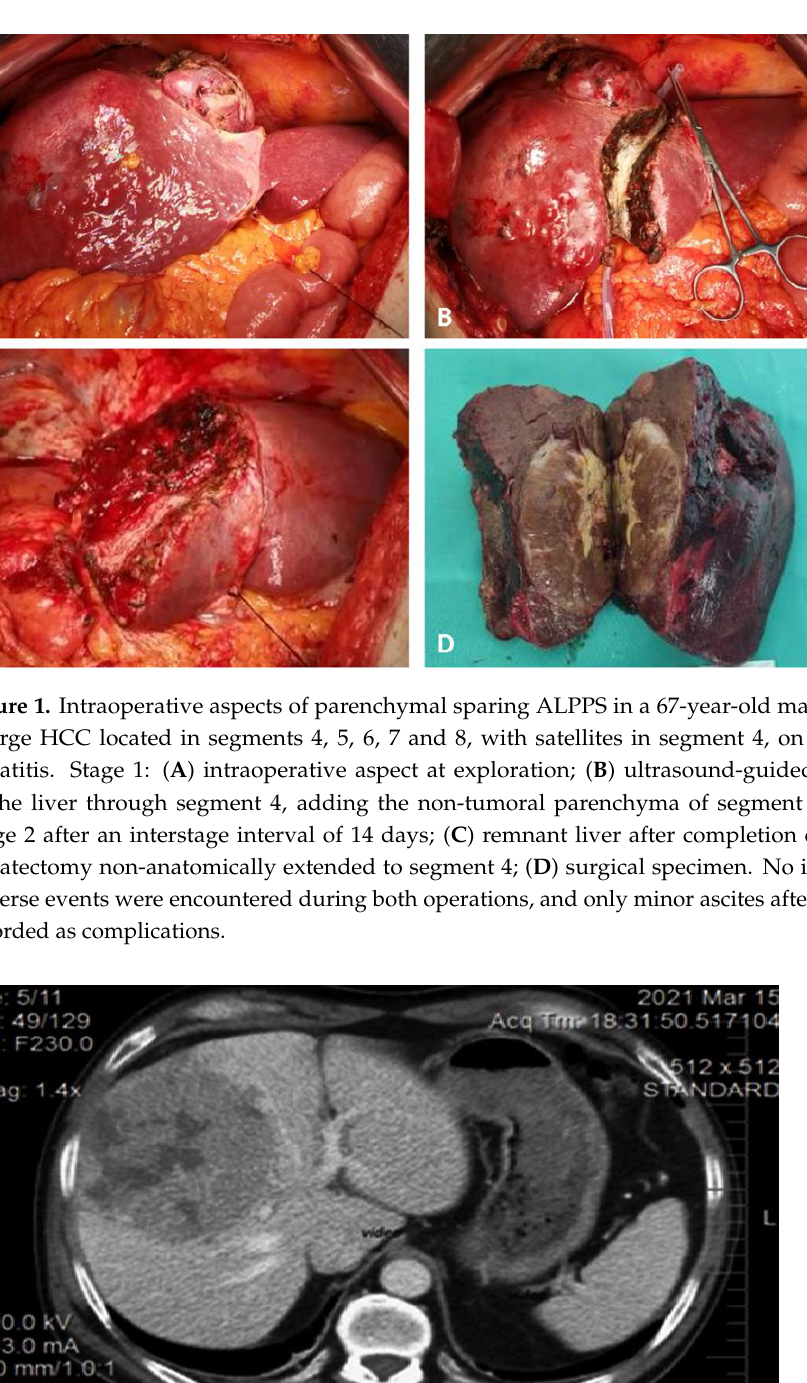
Figure 2. ( A ). Preoperative CT showing the large HCC located in segments 5 and 8 with extension to segments 6, 7, 4, compressing the middle hepatic vein; volumetry: volume of segments 2 and 3 16.8% of total functional liver volume, volume of FLR 27.8%. ( B ) Interstage CT showing the liver partitioning, absence of contrast in the right portal vein (due to ligation), and sufficient growth of FLR (38.5% of total functional liver volume). ( C ) Postoperative CT with well-perfused, non-dilated bile ducts, and tumor-free remnant liver. Besides being the best available tool for identifying and mapping the focal liver le- sions in real time, IOUS increases the safety of ALPPS and its variants by identifying the anatomic variants of the portal vein bifurcation and guiding the right portal vein ligation and the liver transection. 4. Parenchyma-Sparing vs. Regenerative Liver Surgery Interestingly, both strategies have the same origin, as they were basically devised by Makuuchi et al., who pioneered PSS [25] by promoting ultrasound-guided LR and RS by devising portal vein embolization [31]. Even though “siblings”, they become “enemies” caught in the PPS vs. RS debate. However, these strategies are both valid and must be both mastered and used to increase resectability. A major advantage of PSS lies in the lower rate of complications, including postop- erative acute liver failure, due to an insufficient FLR [12], thereby making PSS a useful tool for preventing the “small -for- size” syndrome, while still safe from an oncologica l standpoint [13,14].